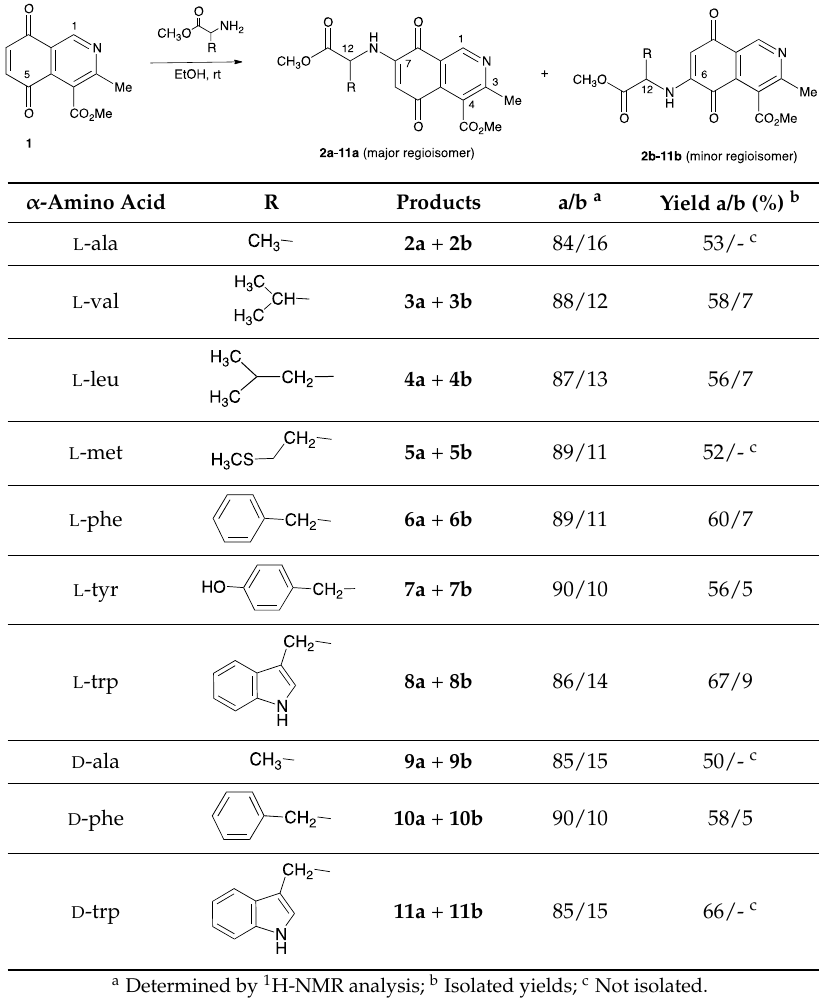
Table 1. Reaction of isoquinolinequinone 1 with α -amino acid methyl esters.